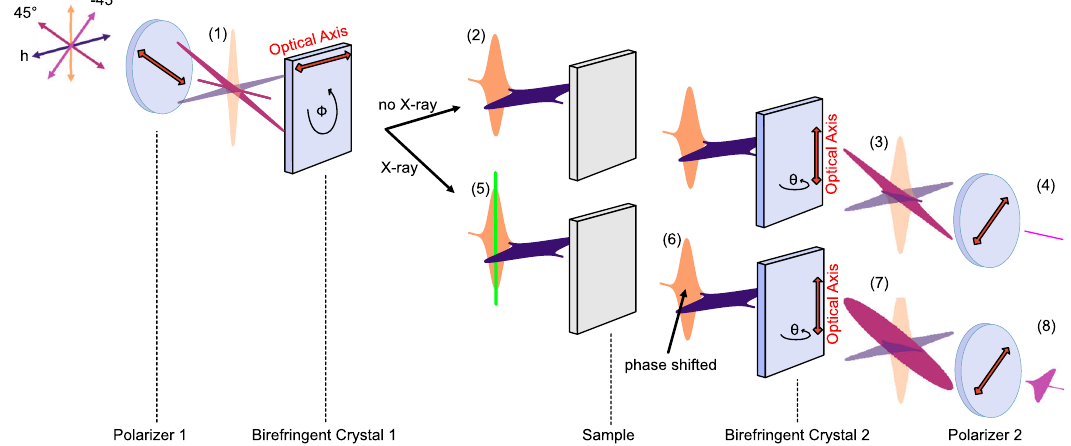
Fig. 10 | Common-path-interferometer principle. The fi rst polariser de fi nes the polarisation of the optical pulse to 45°, which can equally be described by two perpendicularpolarisationcomponents(PCs,1).Nophase-shiftisintroducedinthe absence of anyX-raypulse andthetwo time-delayed PCs(2),generated bythe fi rst birefringentcrystal(BC),canbeperfectlysynchronisedbehindthesecondBC.This